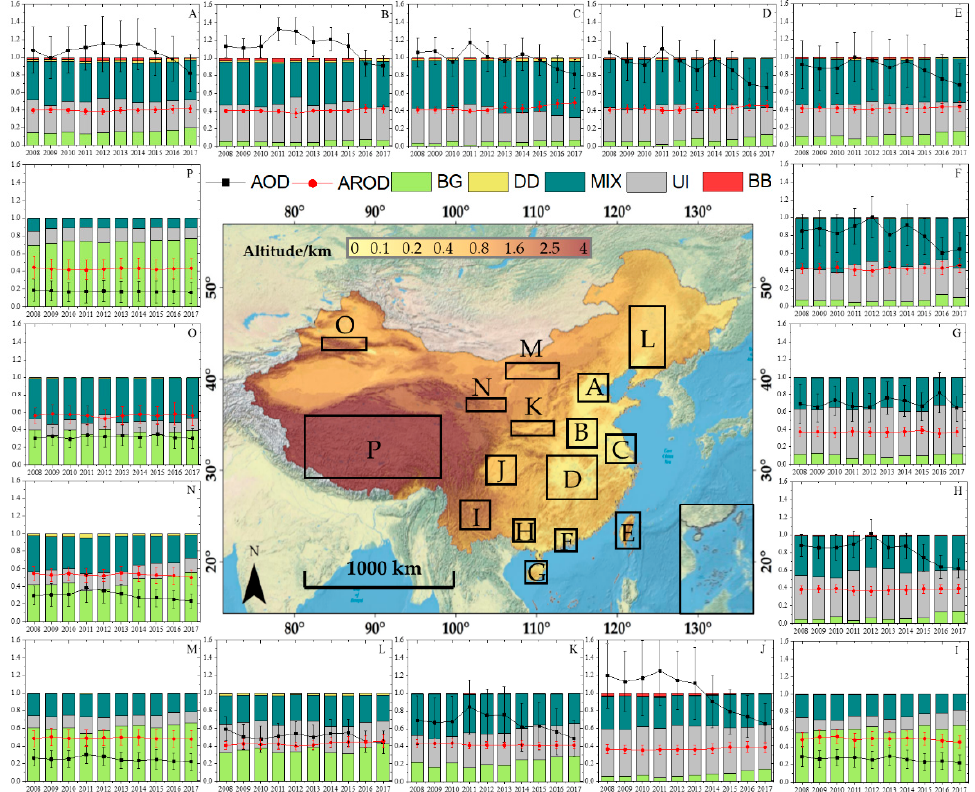
Figure 8. Decadal variation of aerosol types at 16 typical regions over China during 2008 to 2017.